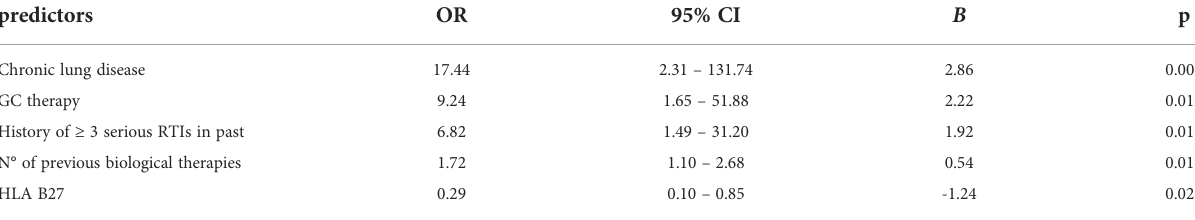
TABLE 2 Multivariate logistic regression analysis of factors associated with LRTIs.